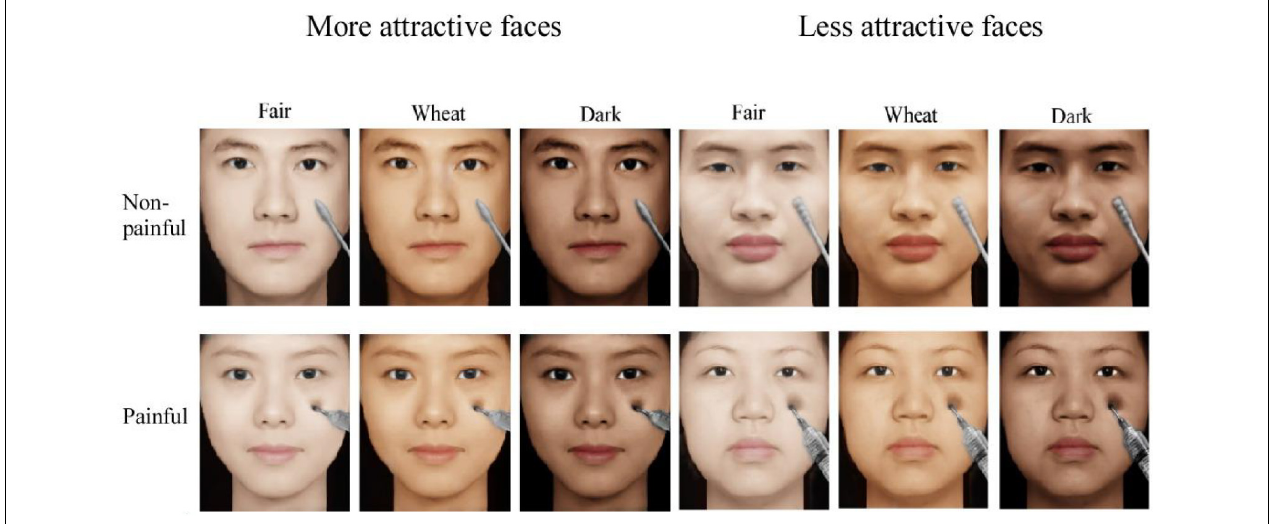
FIGURE 1 | Examples of pictures used in the study. Examples of more (left panel) and less (right panel) attractive faces and painful (top panel) and non-painful (bottom panel) faces with fair, wheatish, and dark skin. Pictures were revised from a picture database that had been validated and used in previous studies Li et al. (2020) and Meng et al.